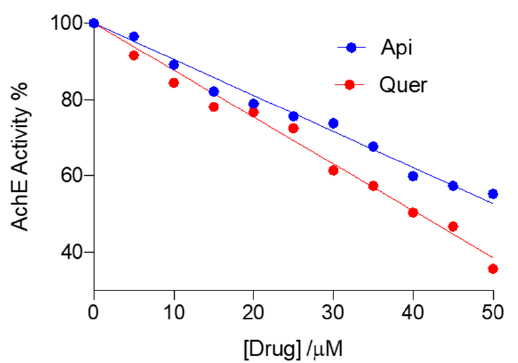
Figure 8. AChE activities as a function of the concentration of flavonoid used, measured spectro- photometrically at 412 nm. The concentrations of apigenin (Api) and quercetin (Quer) flavonoids, i.e., [Drug], range from 0 to 50 μ M; [AChE] = 0.08 U mL − 1 .